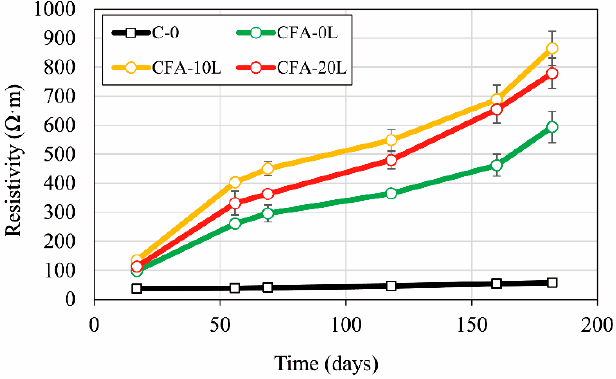
Figure 10. Evolution of concrete electrical resistivity.